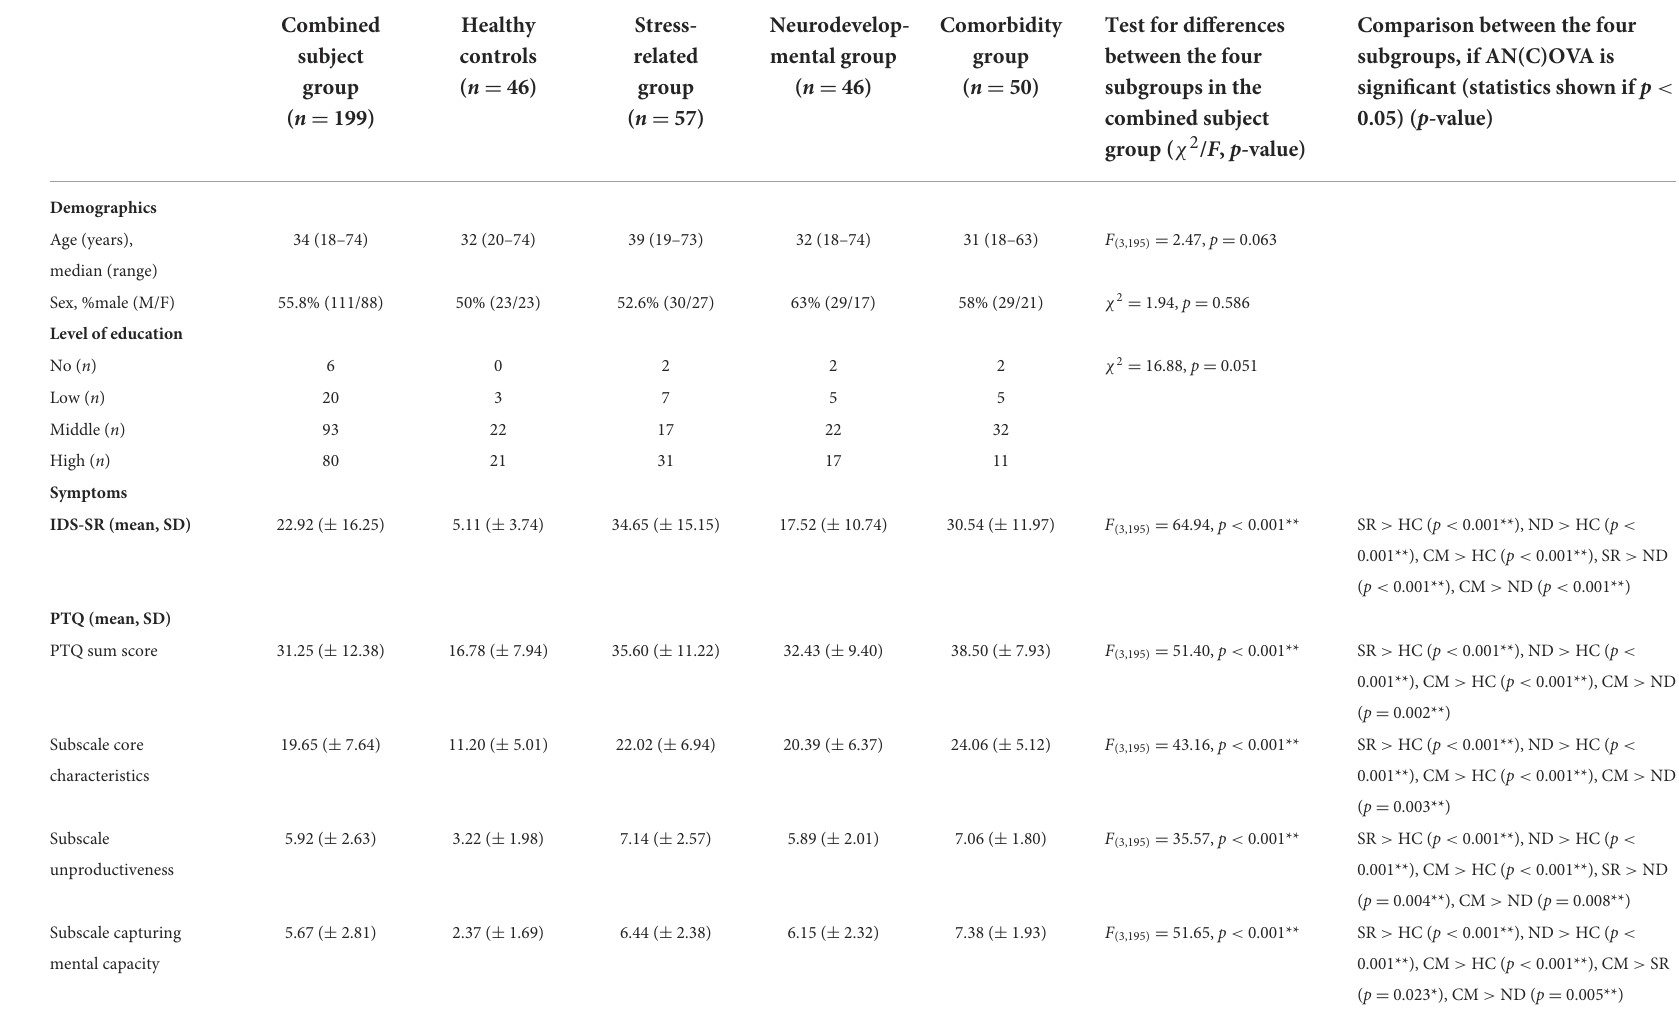
TABLE 1 Demographics and clinical